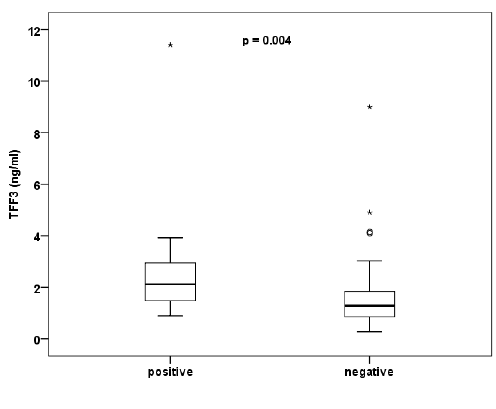
Figure 6: TFF3 serum levels in lymphonode positive (positive, n=14), and lymphonode negative (negative, n=84) endometrial cancer